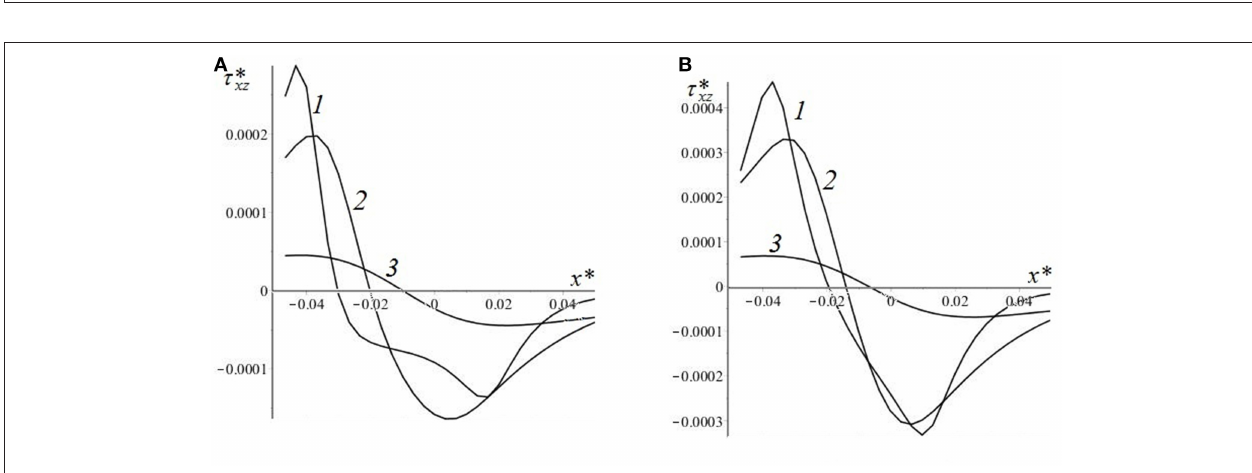
FIGURE 15 | Tangential stresses at the layer-substrate interface [ c = 6; ν = 0.4; Q ′ = 2.0; V ∗ = 0.05 (A) ; V ∗ = 0.2 (B) ; h ∗ = 0.0066 (curve 1), h ∗ = 0.0165 (curve 2), h ∗ = 0.05 (curve